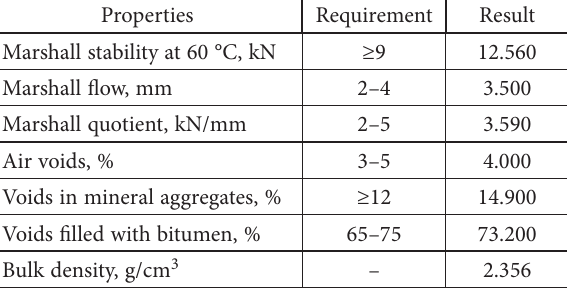
Table 3. Mix design parameters of control DBM mix at OBC Properties